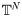
(A) Illustration of pairwise distances between trajectories within an ensemble (X) and across ensembles (Y). Also illustrated are equivalent distances for a single neuron’s state variable θi (Xi, Yi). (B) Pairwise distances between two trajectories for the entire network (on the N-dimensional torus TN, N = 500) as a function of time. (C) Time evolution of pairwise distance distributions for entire network (N = 500), sampled with 100 trials from each ensemble. After a very fast transient (∼ 10-50 ms), distributions settle into stable values. For panels (B,C,E), ρcorr = 0.5. (D) Mean of stationary pairwise distances for a range of similarity parameters ρcorr or ρsame (independently modulated). Shaded areas show one standard deviation. Both mean and standard deviation were averaged over 1000 time points between t = 100 and t = 12,000 ms. (E) Pairwise distances between two trajectories in a single neuron’s coordinate θi as a function of time.